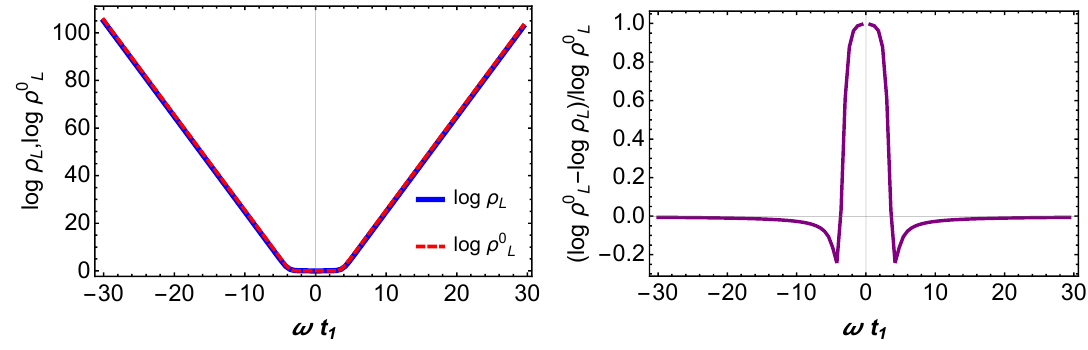
Figure 4 . log ρ vs time for the figure on the right. The parameters is set as δω